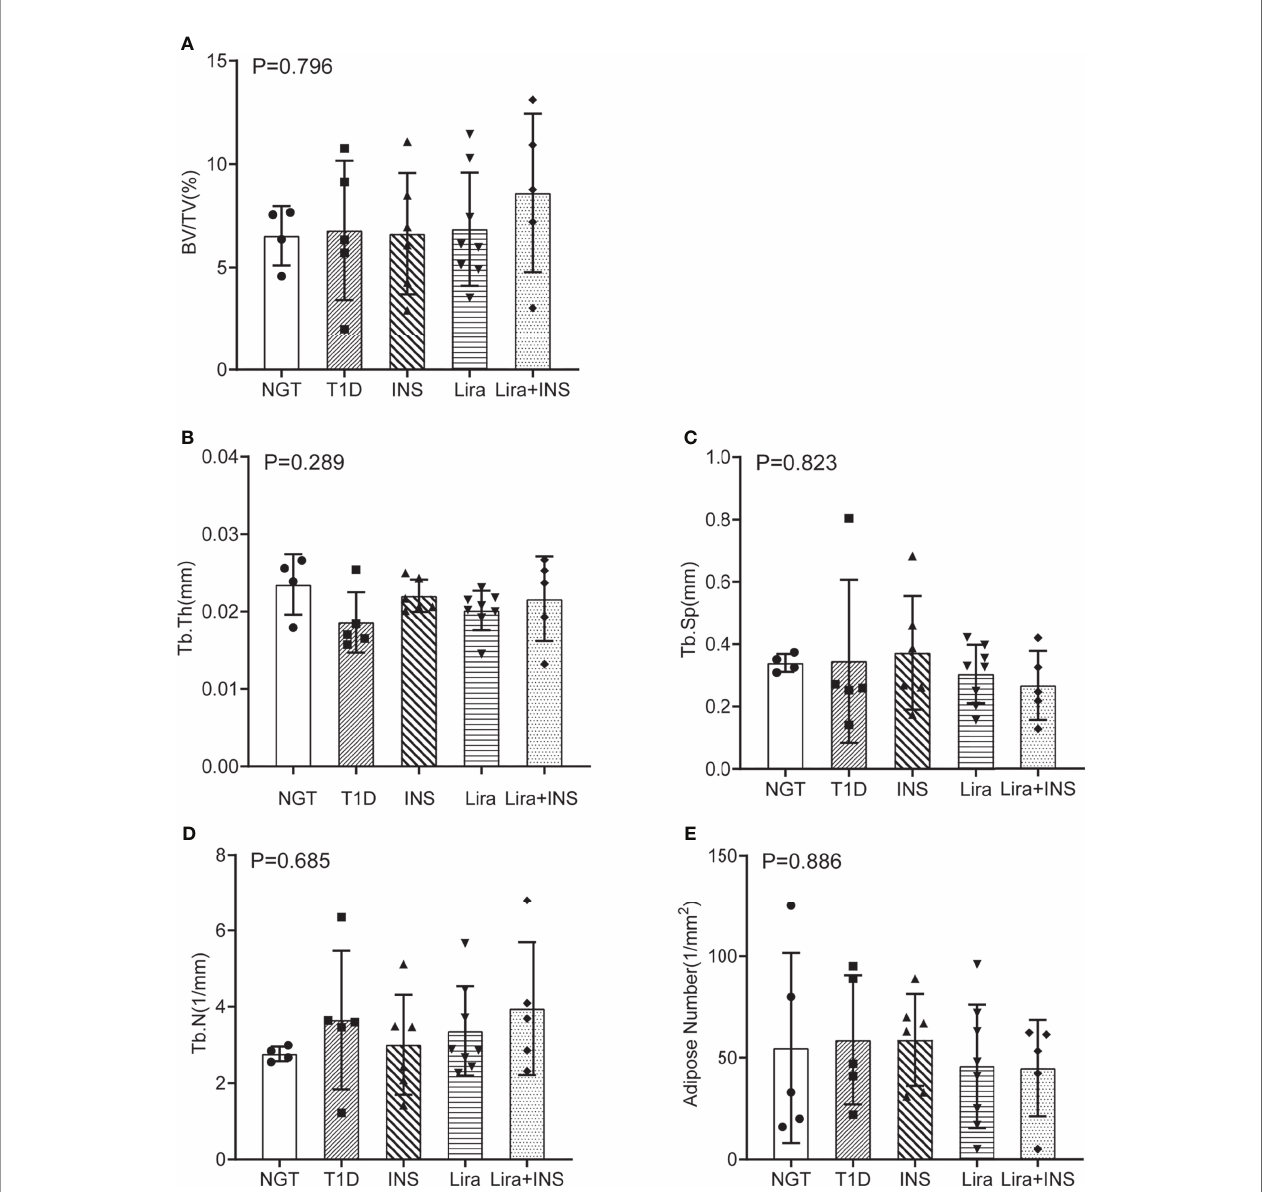
FIGURE 5 | Bone histomorphometry of the femur. (A) Bone volume fraction (BV/TV); (B) trabecular thickness (Tb.Th); (C) trabecular separation (Tb.Sp); (D) trabecular number (Tb.N); (E) adipose number in marrow. NGT, normal glucose tolerance group; T1D, type 1 diabetes group; INS, insulin treatment group; Lira, liraglutide treatment group; INS+Lira, insulin + liraglutide treatment group. ANOVA was used for comparison between groups, and p < 0.05 was de fi ned as statistically signi fi cant. All data are expressed as mean ±